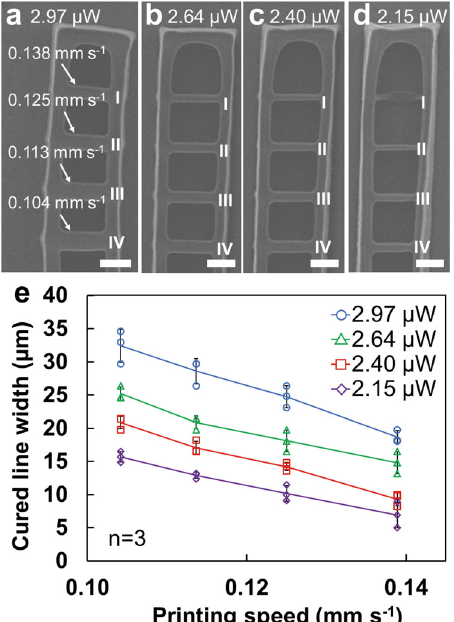
Fig. 4 Laser exposure dose veri fi cation by printing straight lines in a rectangular frame structure at varying printing speed and laser intensity. Scanning electron microscope images of cured lines at laser powers of a 2.97, b 2.64, c 2.40, and d 2.15 µ W (scale bar represents 50 µ m). The printing speed was set to 0.104, 0.113, 0.125, and 0.138 mm s − 1